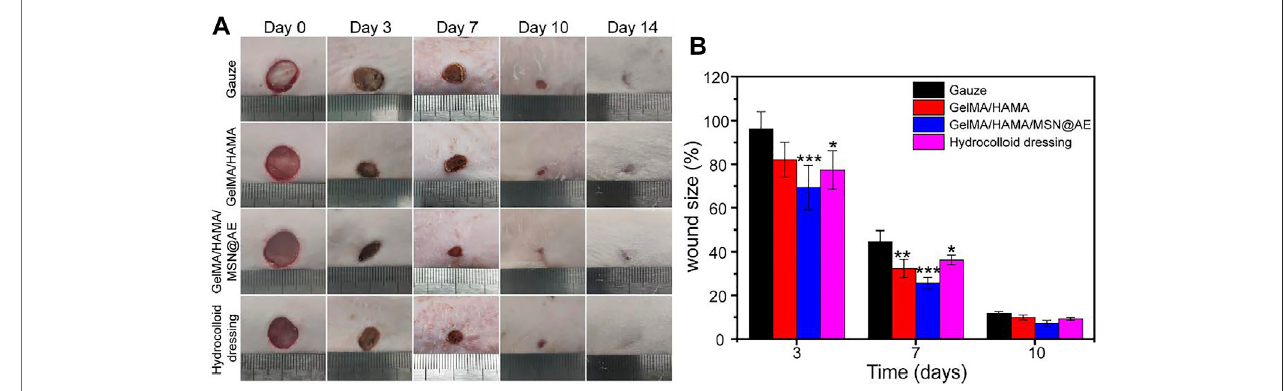
FIGURE 5 | (A) Representative photograph of wounds treated with different materials, including Gauze, GelMA/HAMA hydrogel, GelMA/HAMA/MSN@AE hydrogel, commercially available hydrocolloid dressing at days 0, 3, 7, 10, and 14. (B) The changes of wound size of each